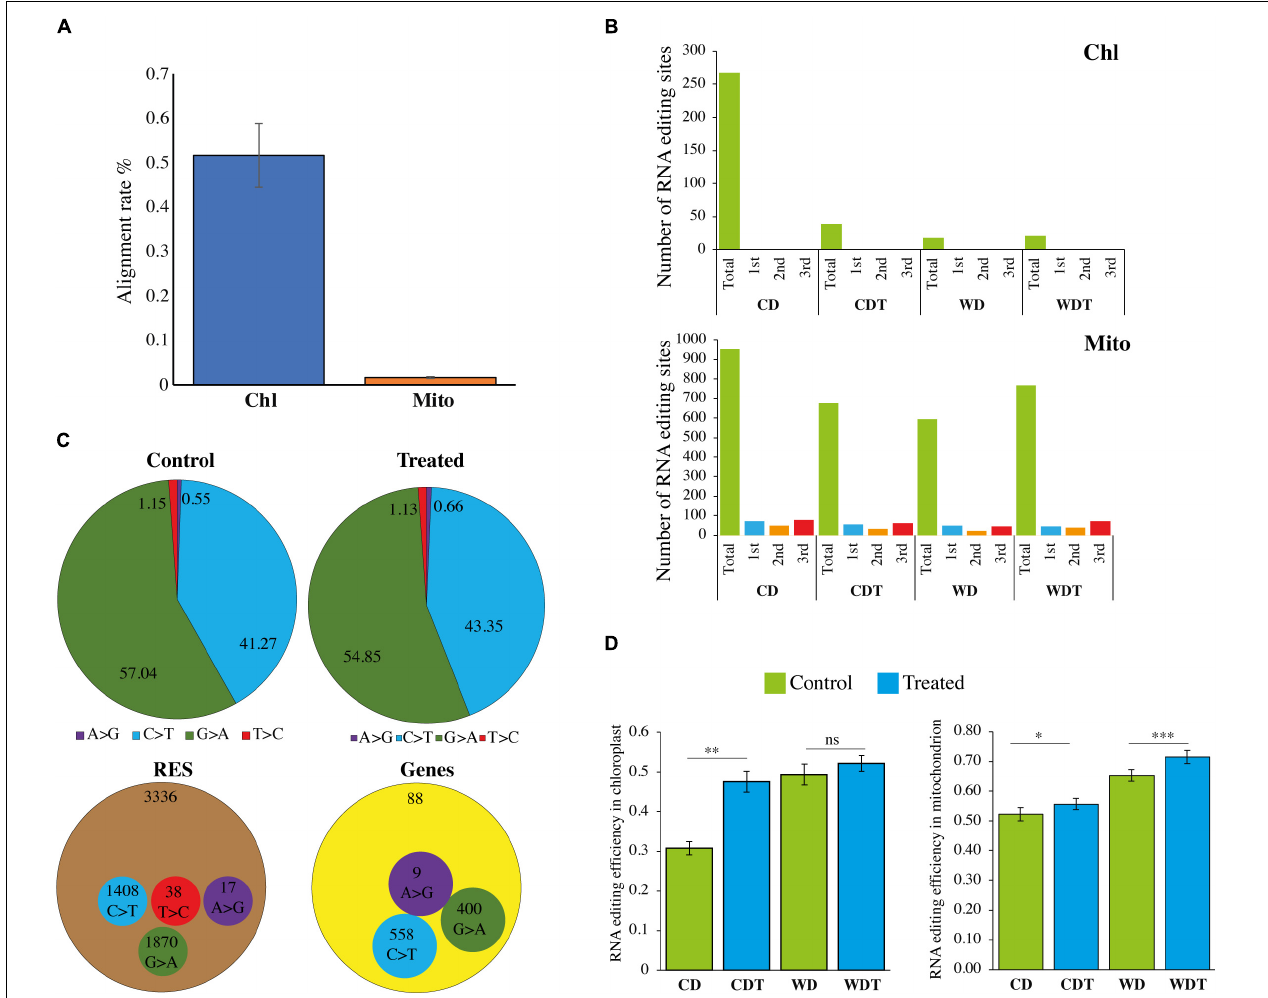
FIGURE 1 | Summary of RNA-seq data. (A) Mapping rate of RNA-seq data of chloroplast (Chl) and mitochondria (Mito). (B) Codon position of RNA editing sites in two genotypes (CD, Caidao and WD, WD20342) of rice, chloroplast (Chl) genome, and mitochondrion (Mito) genomes. (C) Comparison of single nucleotide conversion in control and treated samples by RNA-seq approach. Values are shown by percentage. Number of total RES and edited genes. (D) Editing efficiency of all the RNA sites in rice chloroplast and mitochondrion genomes. For comparison, t -test was used. ∗∗∗ p < 0.001; ∗∗ p < 0.01; ∗ p < 0.05 was used for significant while ns,